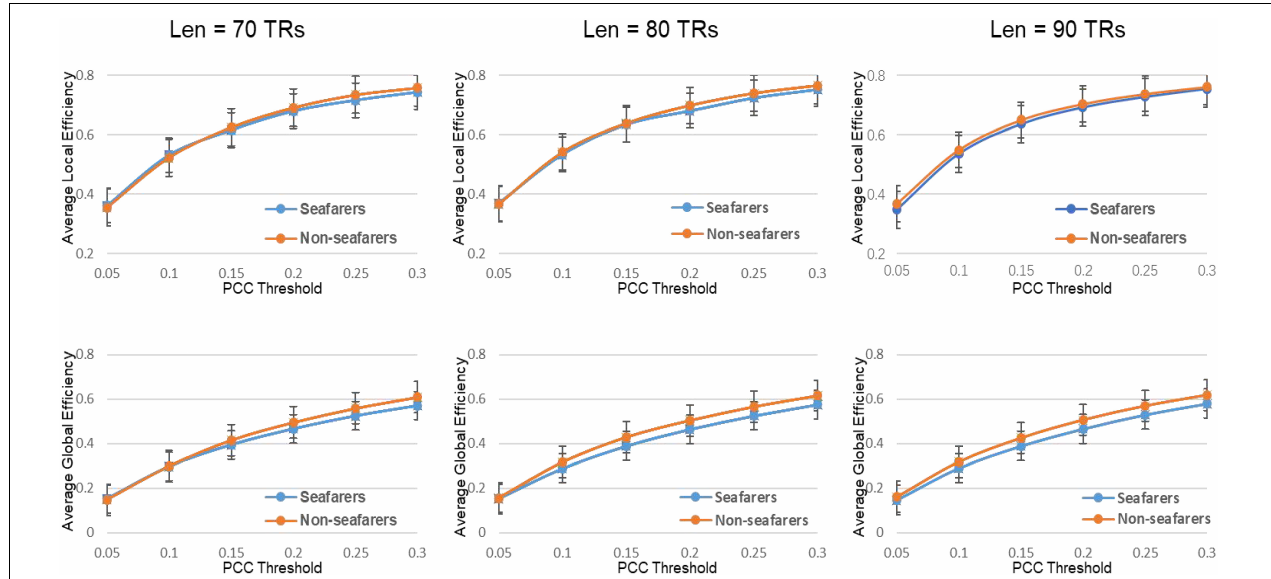
FIGURE 8 | The average value of the efficiency attribute and its parameters of the seafarers and non-seafarers based on brain entropy time series under different window lengths and different thresholds. TABLE 7 | The mean of all network parameters for seafarers and non-seafarers at Len = 70 TRs are presented, as well as the results of two-way ANOVA ( p -value). Properties Groups